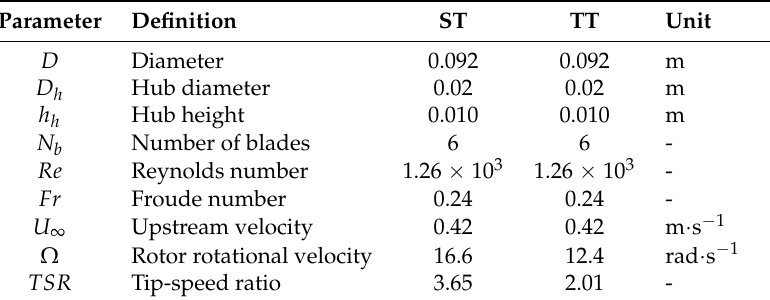
Figure 1. Flume setup for the TT case. Both turbines are aligned and centered. The side-looking Nortek ADV velocimeter is mounted on the DAQ Carriage. Table 1. Primary turbine and flow characteristics for both study